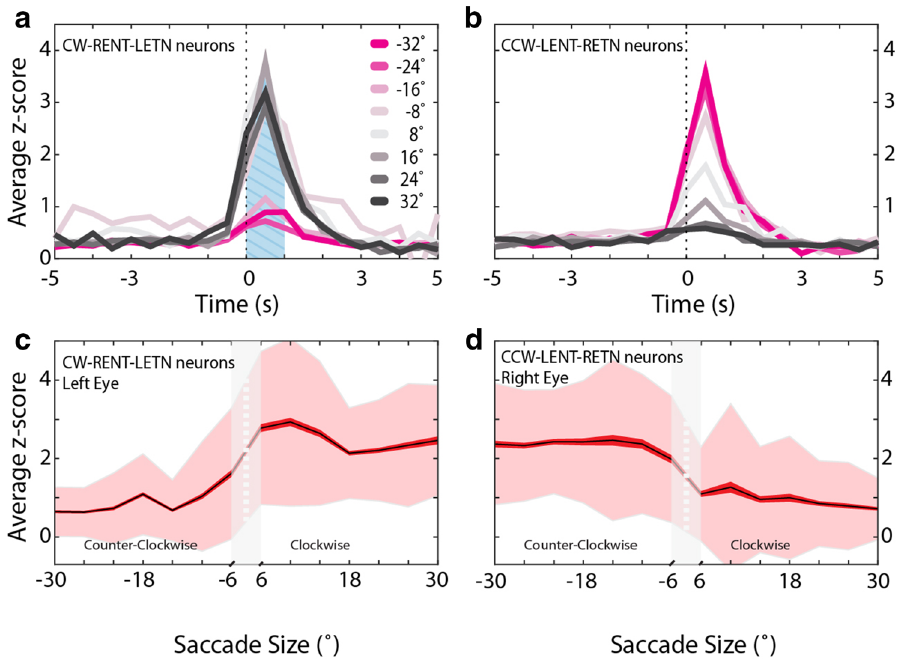
Figure 6. SA neuron tuning to saccade size. ( a , b ) Peri-saccadic activity (calcium z-score) of the two major neuron types encoding conjugate saccades, i.e. neuron types CW-LETN-RENT in ( a ) and CCW-LENT-RETN in ( b ). Activity traces have been stratified according to average binocular saccade size in 8° bins (see color legend). The blue hatched area in ( a ) indicate the z-score time points used for the analysis in ( c , d ). ( c , d ) Separate saccade size tuning curves for the left eye CW ( c ) and right eye CCW ( d ) neurons. Saccade sizes are binned in 4° steps. The black graphs indicate the average z-scores, while red and faint red envelopes indicate the standard error of the mean and the standard deviation,